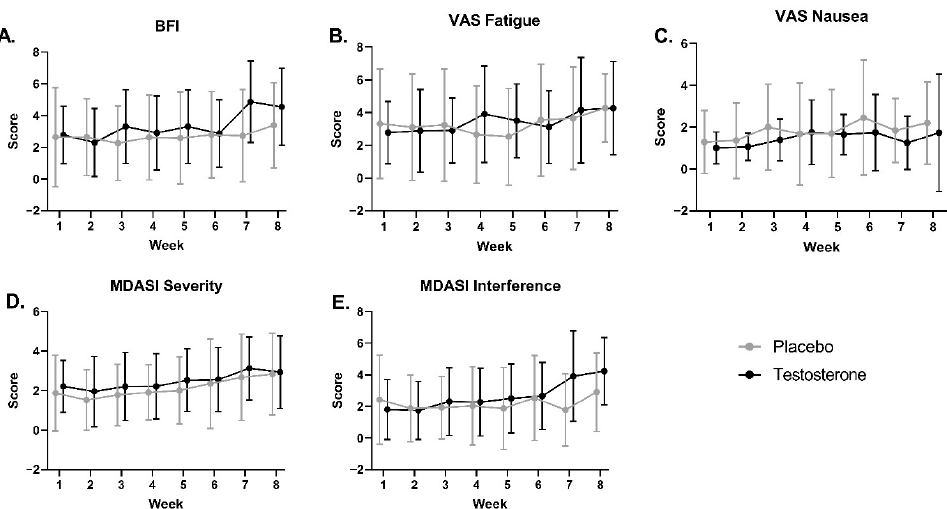
Figure 4. Daily questionnaire scores averaged by week for cancer patients receiving testosterone or placebo. Average ( ± SD) weekly scores for ( A ) Brief Fatigue Inventory—BFI, ( B ) visual analog scale for fatigue—VAS Fatigue, ( C ) visual analog scale for nausea—VAS Nausea, ( D ) MD Anderson Symptom Inventory severity—MDASI Severity, and ( E ) MD Anderson Symptom Inventory interference—MDASI Interference. There were no significant differences between groups or in scores over time for either group. Higher scores on presented questionnaires are undesirable and indicate greater symptom severity.